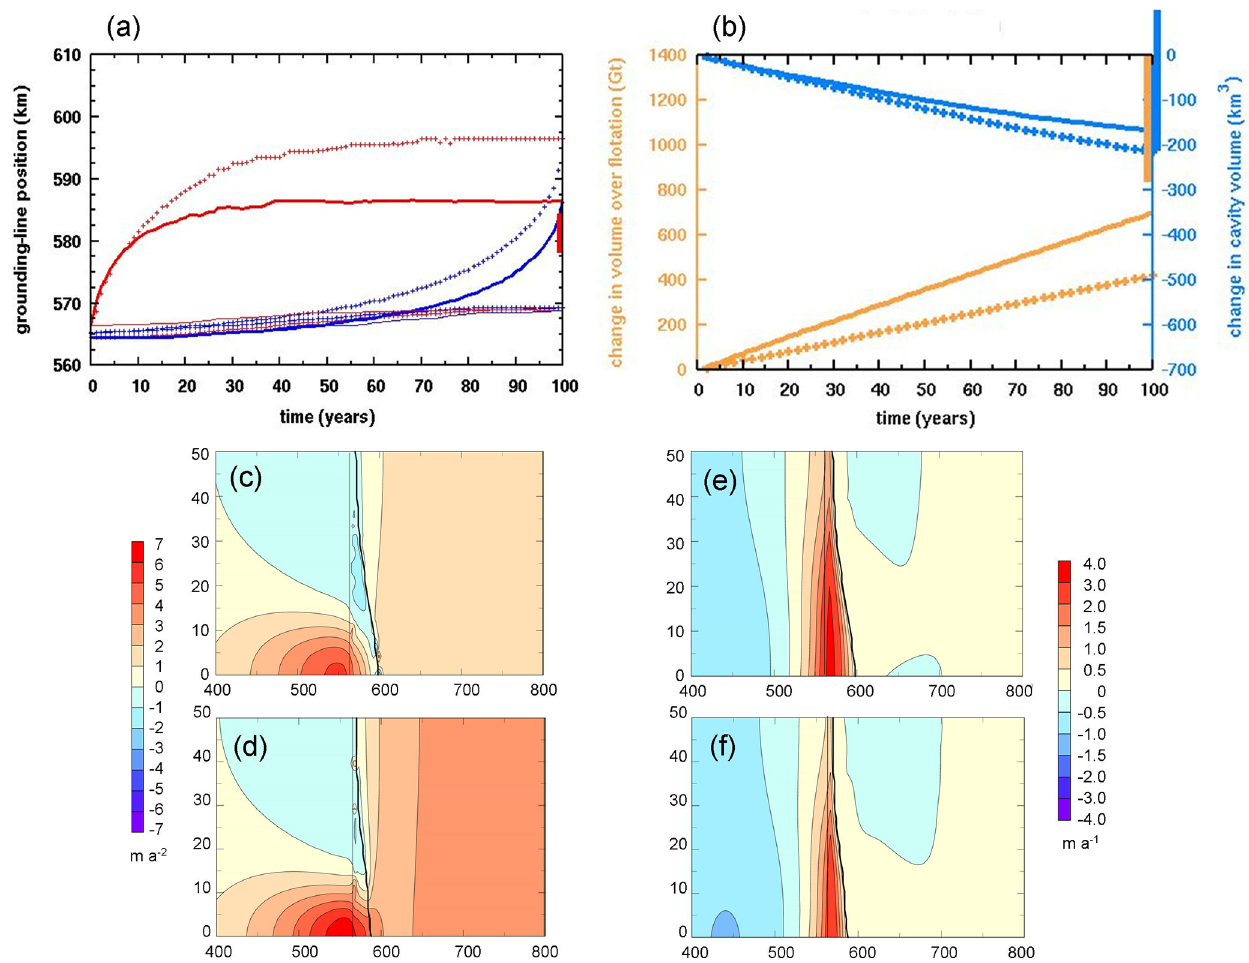
Figure 7. (a) Along-fjord position along the domain x axis (km) of grounding lines in the MISMIP3d experiment (Pattyn et al., 2013). Solid lines: new model version. Crosses: previous model version. Red: advancing grounding lines for 100 years after the perturbation. Blue: retreating grounding lines after the perturbation is removed (reverse time axis). Thick upper lines show centerline positions, and thin lower lines show positions at the domain edge. The vertical red bar on the right-hand y axis shows the range of amplitude of centerline excursions at 100 years for other model categories in the intercomparison (from Pattyn and Durand, 2013, Fig. 1). (b) Yellow: changes in total ice volume over flotation (multiplied by ice density, Gt of ice), for a half domain from the centerline to one y -axis edge (as in Pattyn and Durand, 2013). Blue: changes in total cavity volume under floating ice (km 3 ), for the same half domain (ibid). Solid lines vs. crosses denote new vs. previous model versions as in panel (a) . The vertical yellow bar on the right-hand y axis shows the volume-over-flotation range at year 100 for the other model categories in the intercomparison, and the vertical blue bar shows the same range for cavity volume (from Pattyn and Durand, 2013, Fig. 4). (c, d) Mean rate of change in ice surface speed from year 0 to year 100 (myr − 2 ) is as in Pattyn and Durand (2013, Fig. 2). (e, f) Mean rate of change in ice surface elevation from year 0 to year 100 (myr − 1 ) is as in Pattyn and Durand (2013, Fig. 3). Panels (c, e) are for the previous model version, and (d, f) are for the new model version. In panels (c–f) , thin and thick black lines show the position of the grounding line at years 0 and 100,